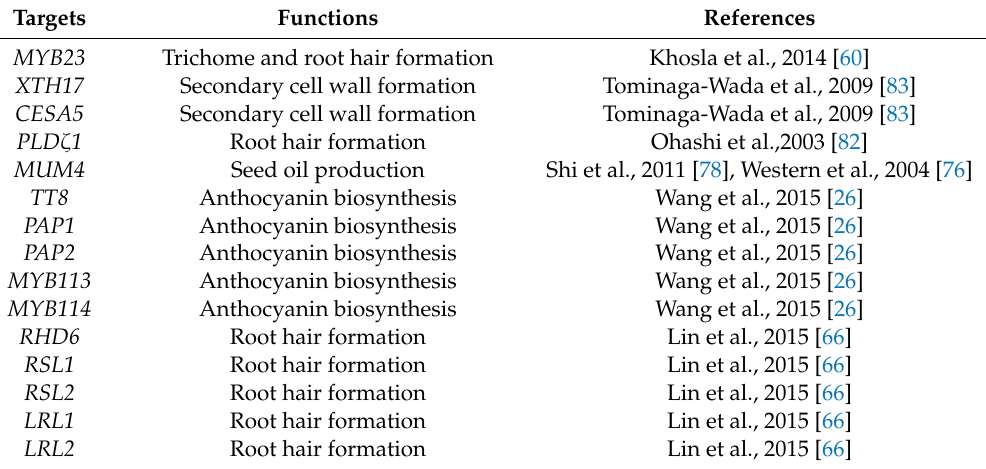
Table 1. Confirmed target genes of GL2 and their functions in